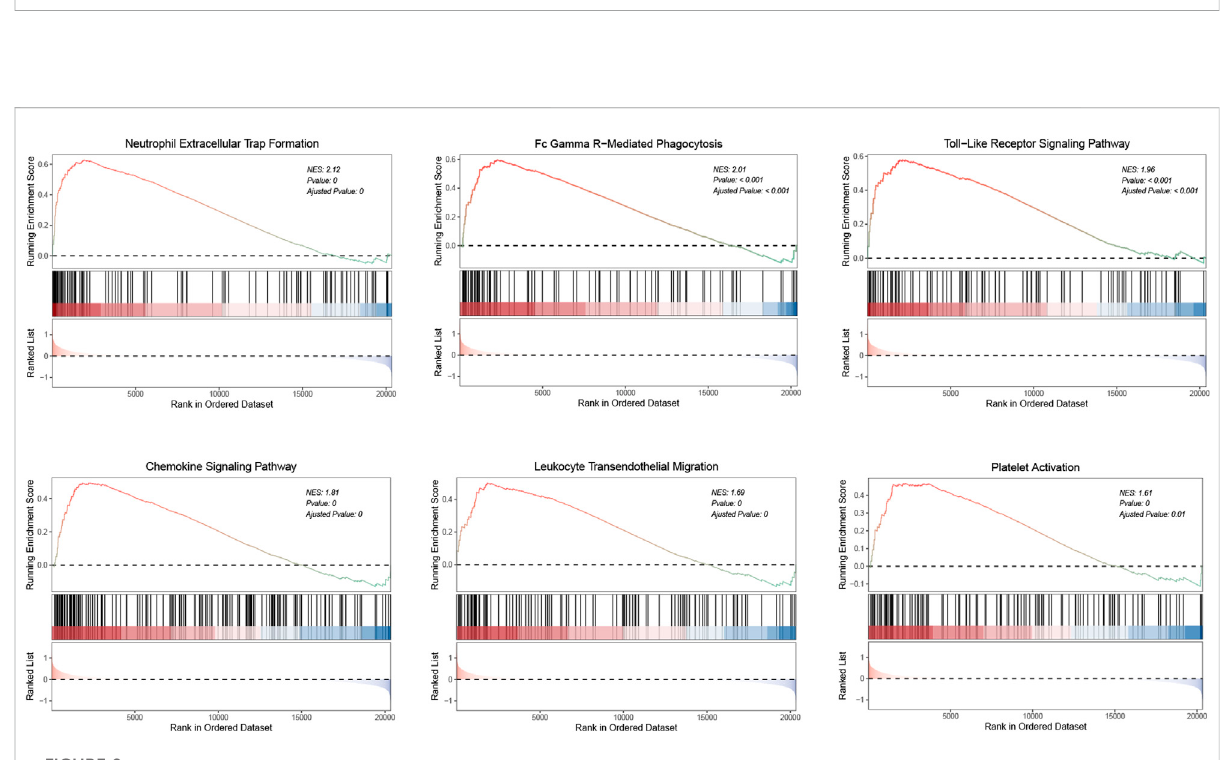
FIGURE 9 GSEA analysis illustrates the activated pathways in aSAH. The normalized enrichment scores (NES) and p values are indicated in each